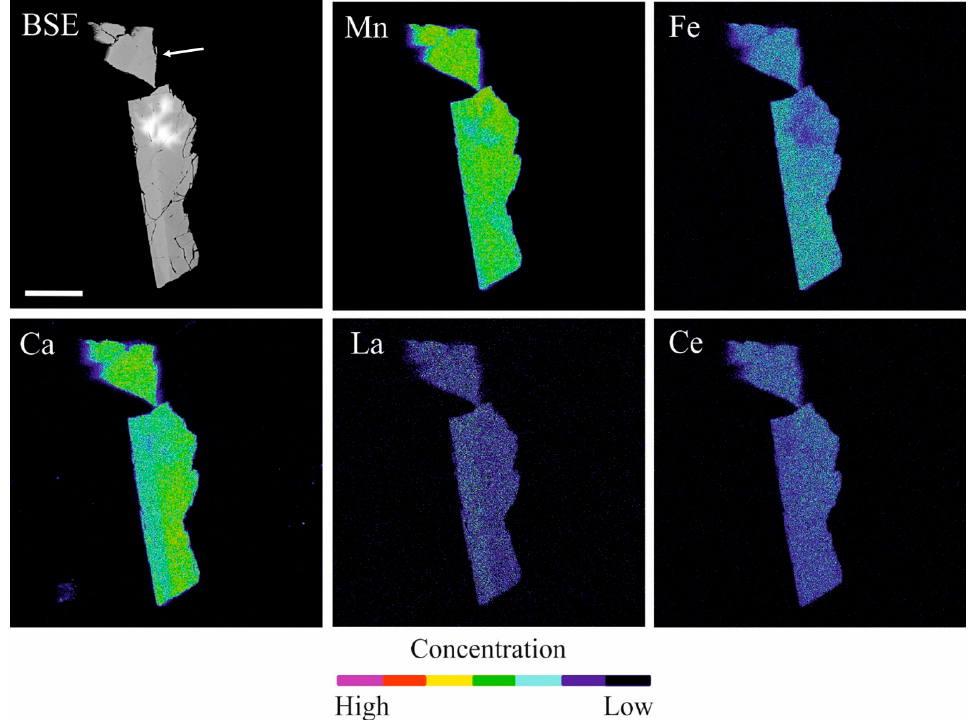
Figure 2. Back-scattered electron (BSE) image and X-ray maps of sample #19903-1, showing the distribution of Mn, Fe, Ca, La, and Ce. In the BSE image, the bright areas are due to the charging of the surface. The smaller grain used for single-crystal X-ray diffraction is indicated by a white arrow in BSE image. Scale bar = 50 μ m.